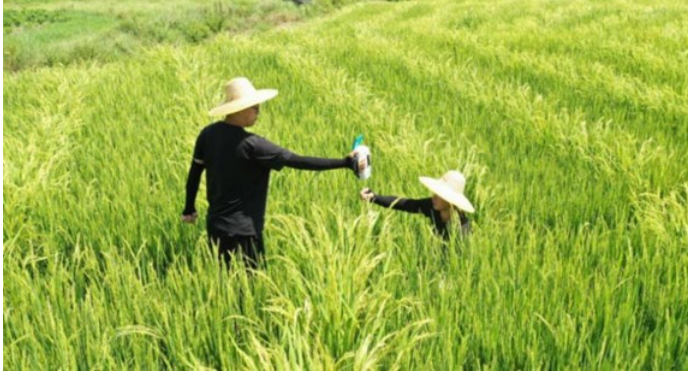
Figure 2. Hyperspectral data acquisition of rice spikelets.